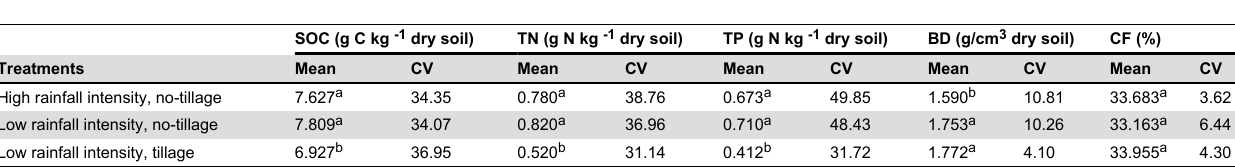
Table 1. Spatial trends of soil properties within each block and their discrepancy between different treatments after a simulated